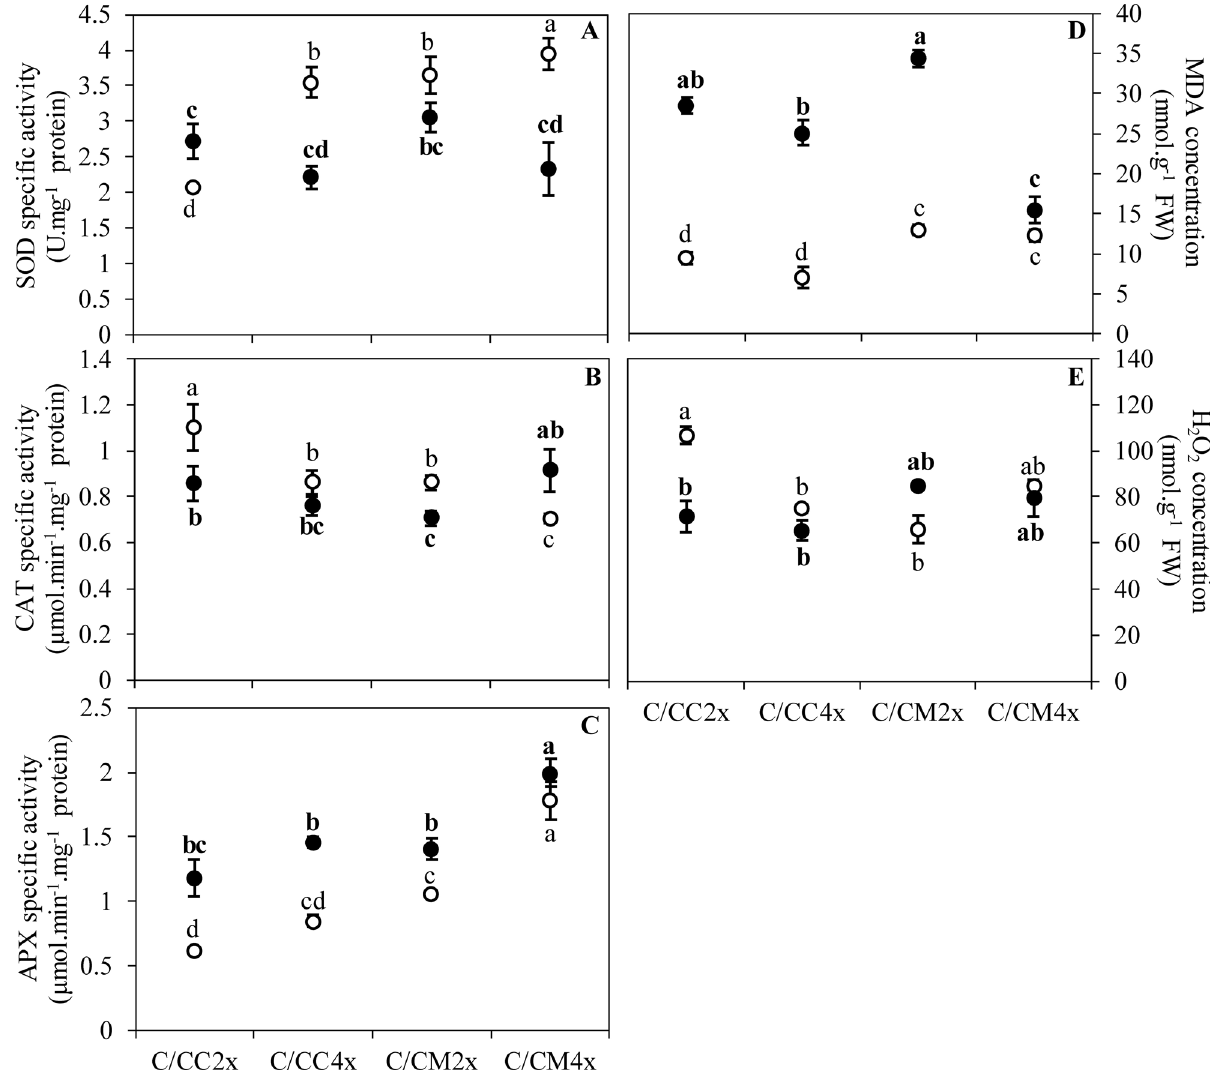
Figure 6. Effect of nutrient deficiency on antioxidant enzyme activities and contents in oxidative compounds in leaves of common clementine scion grafted onto different rootstocks. ( A ) Superoxide dismutase (SOD), ( B ) catalase (CAT) and ( C ) ascorbate peroxidase (APX) specific activities and ( D ) malondialdehyde (MDA) and ( E ) H 2 O 2 contents in leaves of common clementine scion grafted onto diploid (C/CC2x) and doubled diploid (C/CC4x) Carrizo citrange and diploid (C/CM2x) and doubled diploid (C/CM4x) Citrumelo 4475 rootstocks grown in nutrient reference solution (100%) (white circles) and without nutrient solution (0%) (black circles) for 210 days. Values are mean (± standard error) of 3 independent measurements from 3 samples for each scion/rootstock combination, i.e. one per tree, obtained by pooling 8 fully-expanded leaves ( n = 3). Ploidy and treatment effects were analyzed using ANOVA and Fisher LSD tests ( p < 0.05). Distinct letters indicate significant differences between the four scion/rootstocks combinations and